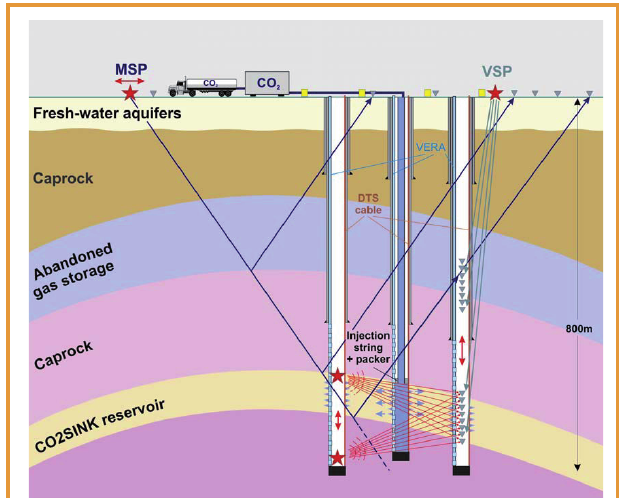
Figure 2. Schematic concept of Ketzin geology, drilling, and geophysical monitoring including moving source seismic profiling (MSP), vertical seismic profiling (VSP), cross-hole seismics, surface 3-D seismics, and surface and cross-hole geoelectrics using a per- manently installed Vertical Electrical Resistivity Array (VERA), and Distributed Temperature Sensing (DTS) (from Förster et al., 2006).